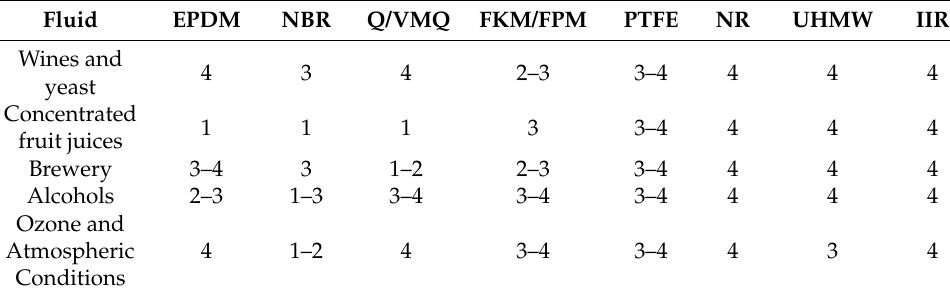
Table 1. Compatibility of materials used in the manufacture of hoses and seals against different